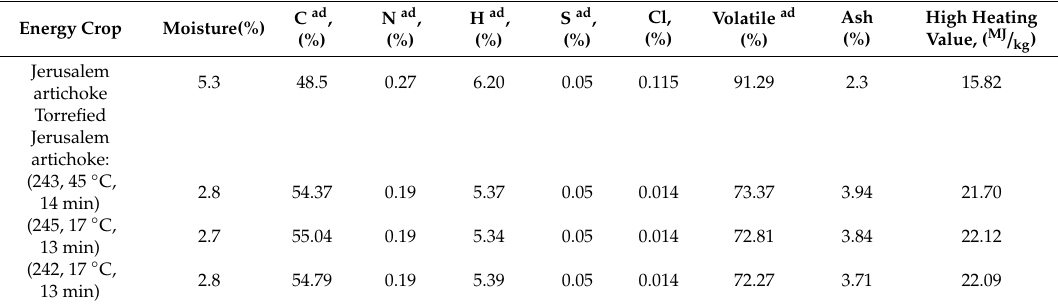
Table 3. Elemental analysis and technical analysis of Jerusalem artichoke before and after the torrefaction process.